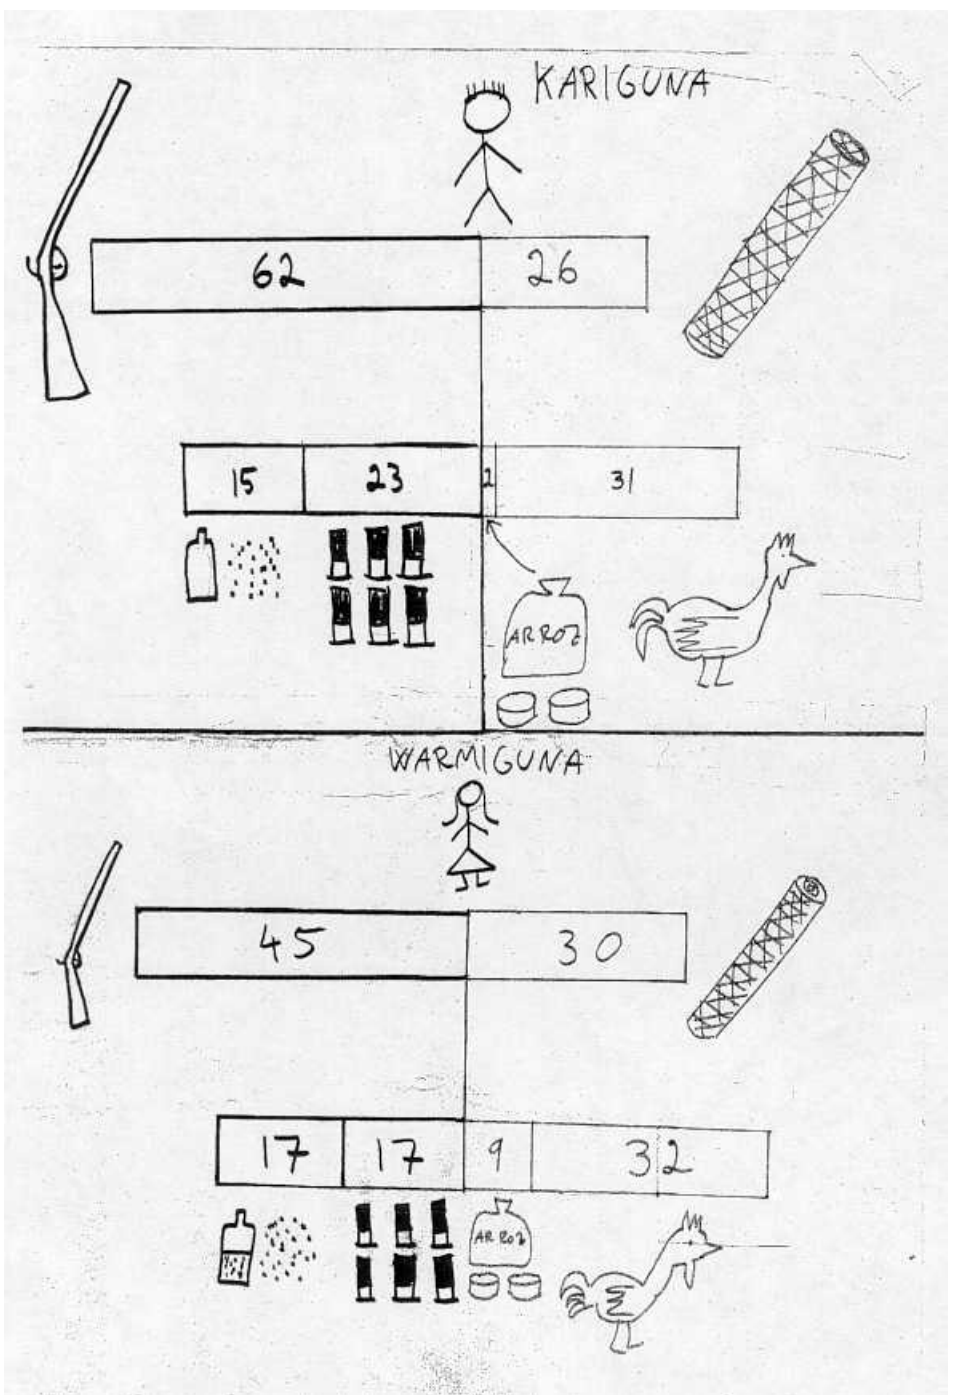
Fig. 5. Results split according to